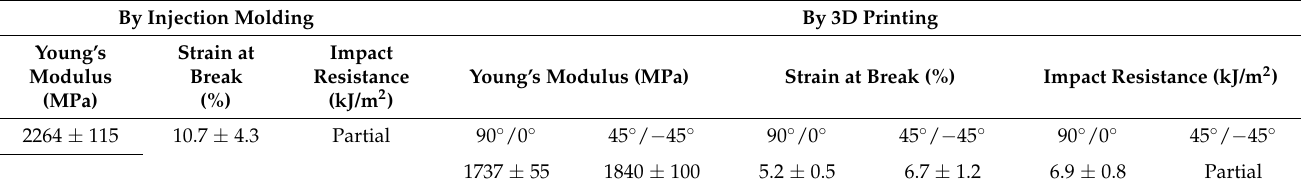
Table 3. Mechanical properties (tensile and impact tests) of pristine ABS specimens prepared by injection molding or 3D printing using two raster angles (90 ◦ /0 ◦ and 45 ◦ / − 45 ◦ ).